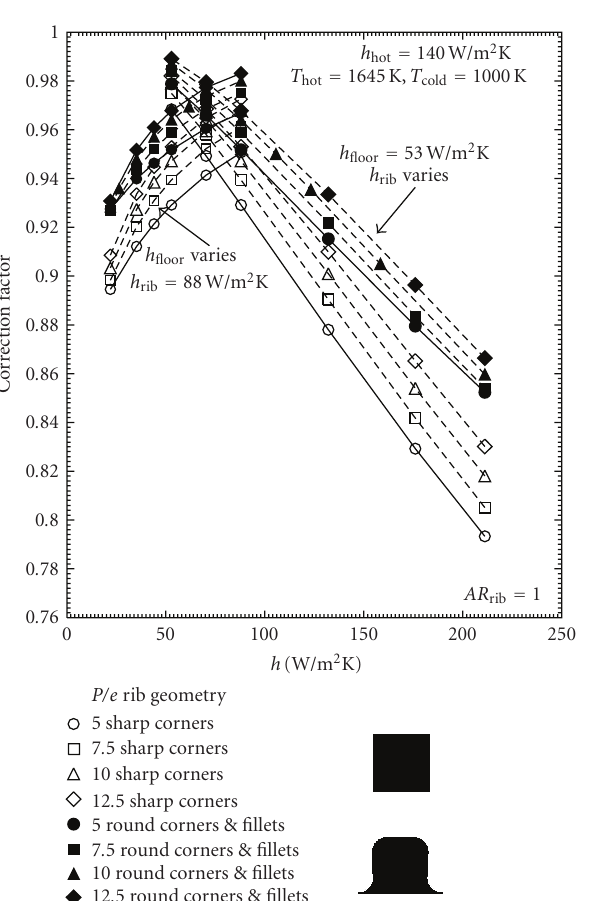
Figure 6: Correction factor variation with h rib and h floor for a rib aspect ratio of 1.